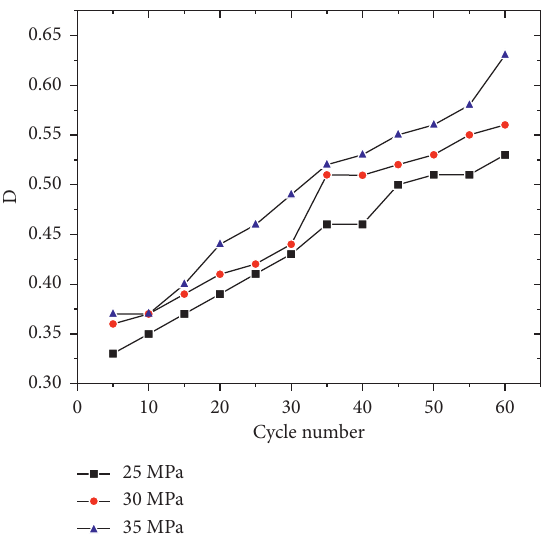
Figure 6: Variation law of damage variable D of the concrete with the cycle number C under different stress amplitudes.